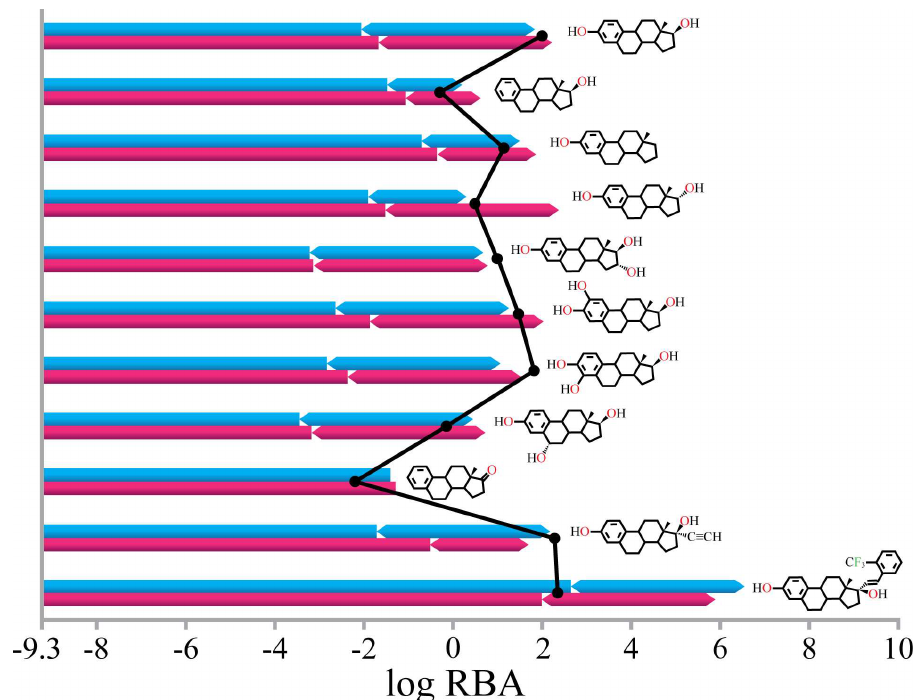
Fig 5. Prediction of RBA of 17 β -estradiol derivativesbased on protein-ligand complex structures from crystal structure modification (blue bars) or molecular docking (red bars). RBA is describedby contributions from hydrophobiccontacts (rectanglebars) and hydrogen bonds (hexagon bars). Black dots representthe experimental log